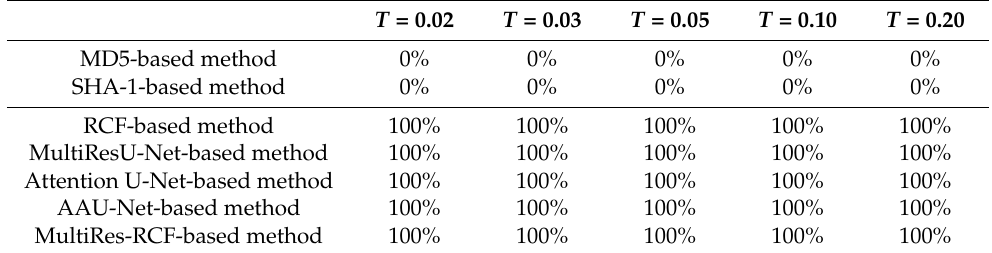
Table 5. Robustness test comparison of format conversion (TIFF format to PNG format, no compression).